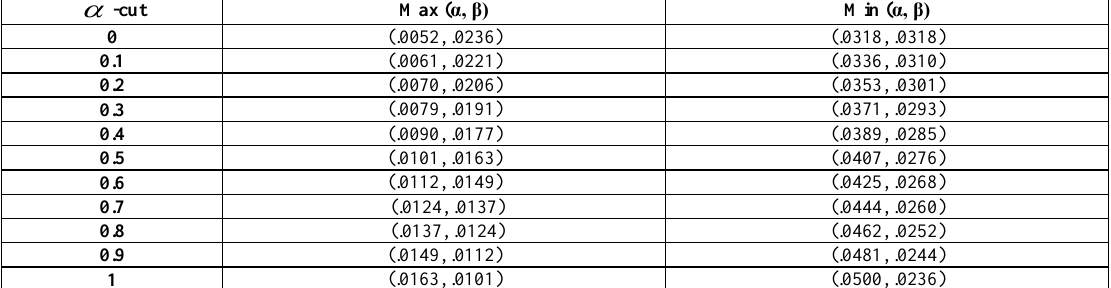
Table 5. Reliability of the linear system.